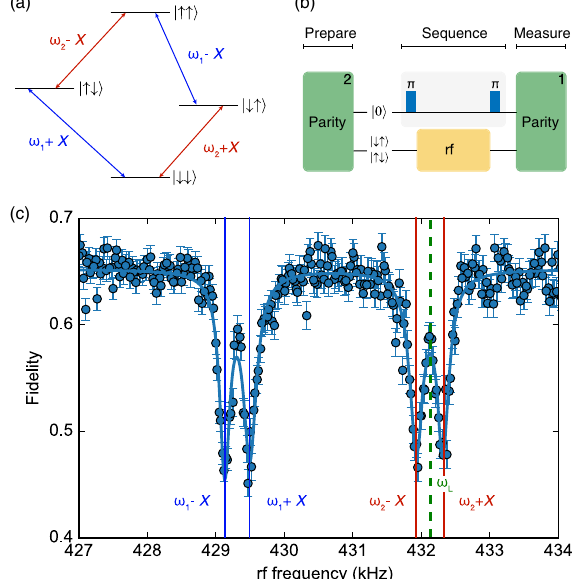
FIG. 8. Spectroscopy and control of the complete pair Hilbert space. (a) Level diagram for pair C with the electron spin in m − 1 . ω ω s ¼ 1 ( 2 ) is the frequency associated to the first (second) spin of the pair with the NV in m s ¼ − 1 . (b) Sequence to reveal the transitions between the subspaces. First, the pair is initialized in the antiparallel subspace through a parity measurement, then an rf pulse with variable frequency with the NV in m s ¼ − 1 is applied, and finally the subspace population is measured using another parity measurement. If the frequency of the rf pulse is resonant with a single-spin transition, the spin pair changes its subspace. (c) Measurement result. Four transitions are ob- served corresponding to the marked transitions in (a). The green dashed line corresponds to the bare Larmor frequency ω 432 . 140 kHz. We fit the data to four Lorentzians and L ¼ extract ω 1 ¼ 429 . 314 ð 5 Þ kHz and ω 2 ¼ 432 . 122 ð 7 Þ kHz. For the left (right) dips, we also obtain X ¼ 184 ð 3 Þ [194(4)] Hz. These results corroborate the assignment of the signals to 13 C pairs and enable complete control over the full pair